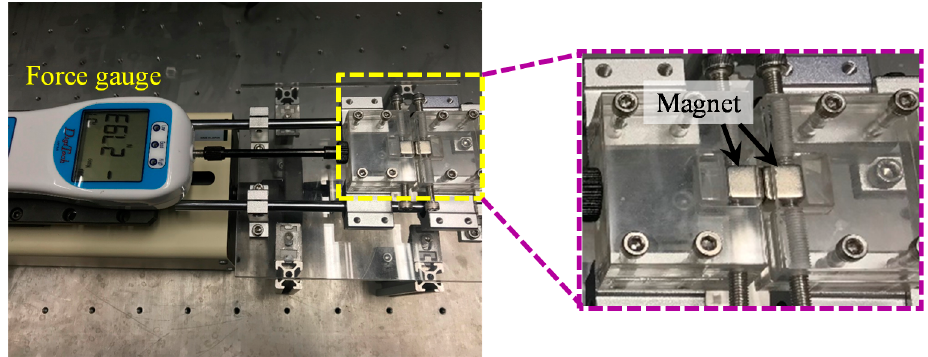
Figure 5. The experimental setup for the magnetic force measurement.